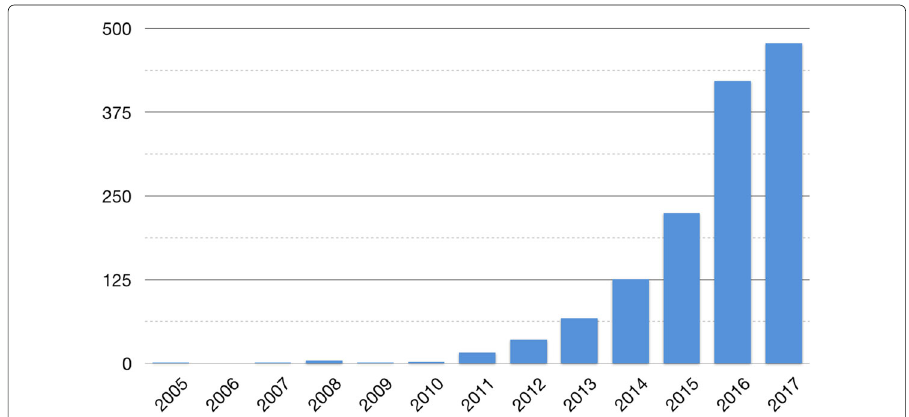
Fig. 1 Papers containing the term “startup ecosystem.” Source: Google